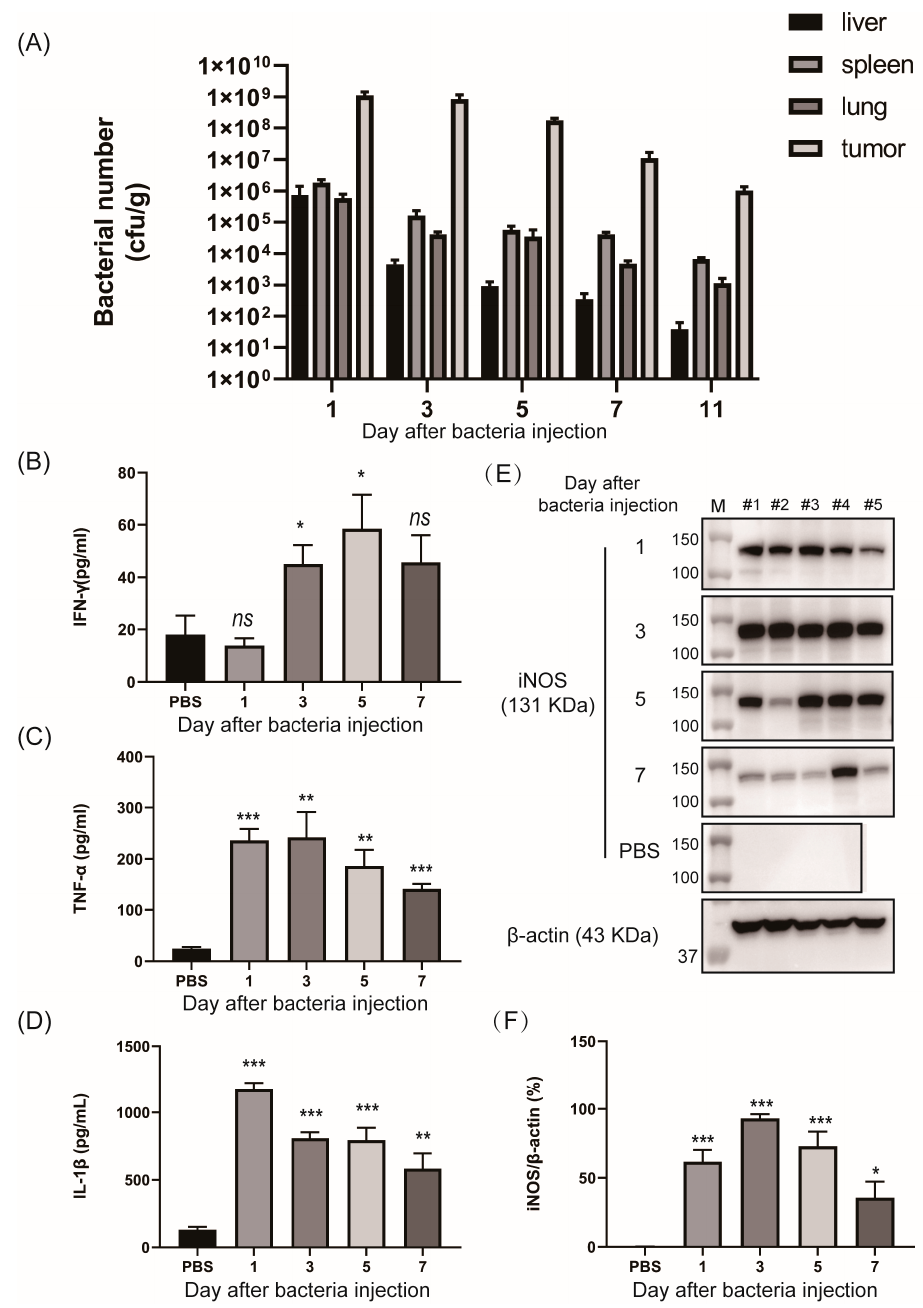
Figure 5. In vivo assessment of tumor microenvironment modulation after bacterial colonization. CT26-bearing mice inoculated with 1 × 10 7 CFUs of SL . pNASR ( n = 5) or PBS ( n = 4) were sacrificed on days 1, 3, 5, and 7. ( A ) Numbers of bacterial cells colonizing normal organs (liver, spleen, and lungs) and tumor tissues. ( B – D ) Tumor concentrations of the proinflammatory cytokines ( B ) IFN- γ , ( C ) TNF- α , and ( D ) IL-1 β on indicated days post-injection. ( E ) Western blot determination of iNOS expression in tumors. ( F ) Quantification of iNOS expression level normalized to β -actin (%). Error bars represent the mean ± SEM. * p < 0.05, ** p < 0.01, and *** p < 0.001; ns, not significant, as determined by Student’s t -tests.